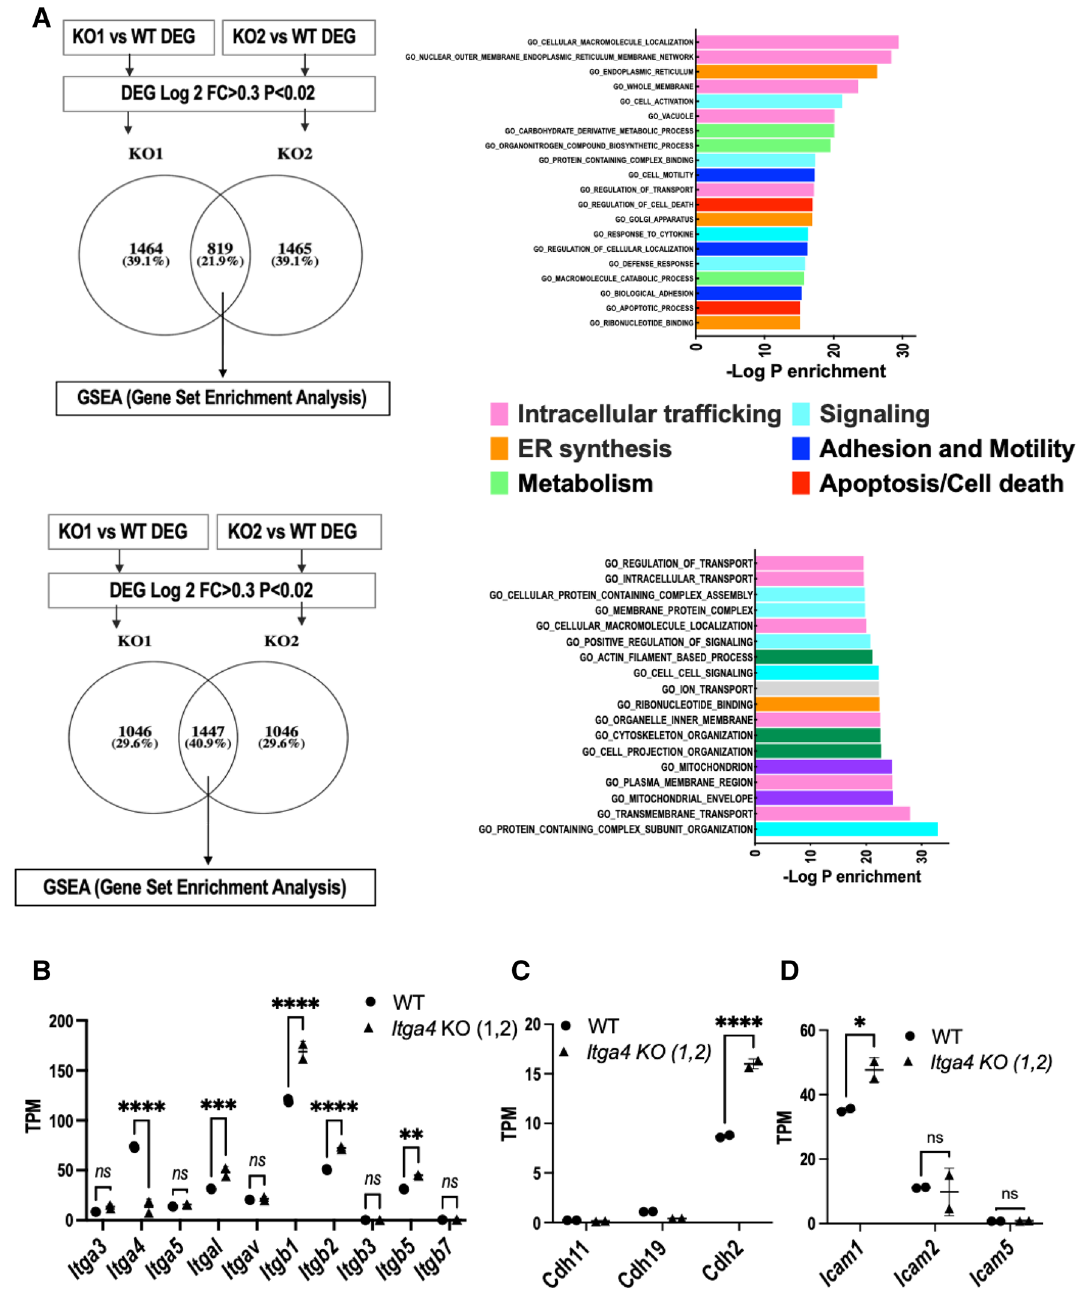
Figure 1. Gene set enrichment analysis (GSEA) of differentially expressed genes (DEG) by RNAseq of WT vs Itga4 KO 5TGM1 cells. ( A ) Identification of upregulated (top) and downregulated (bottom) genes (left), and gene ontology analysis (right). Gene ontology results from GSEA were plotted as negative Log of P value for gene set enrichment and color coded for involvement in intracellular membrane or protein trafficking (pink), synthesis and secretion of secretory proteins from co-translational entry in the Endoplasmic Reticulum (ER) to the Golgi apparatus (orange), signaling (light blue), cell adhesion and motility (blue), metabolism (light green), cell death (red), cytoskeleton (green), and mitochondria (purple). ( B – D ) univariate analysis of expression of adhesion molecules ( A ) integrins, ( B ) cadherins, ( C ) intercellular adhesion molecules * p < 0.05, ** p < 0.01, *** p < 0.001, **** p < 0.0001, ns non